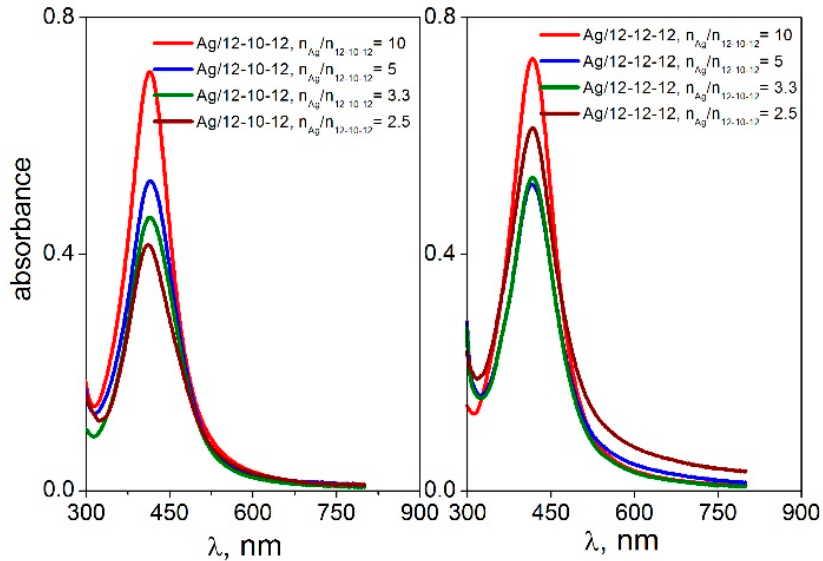
Figure 1. UV-VIS spectra of silver nanoparticles stabilized with gemini surfactants 12- s -12 with the spacer length s = 2, 4, 6, 8 methylene groups, at different molar ratio values n Ag /n 12- s -12 .